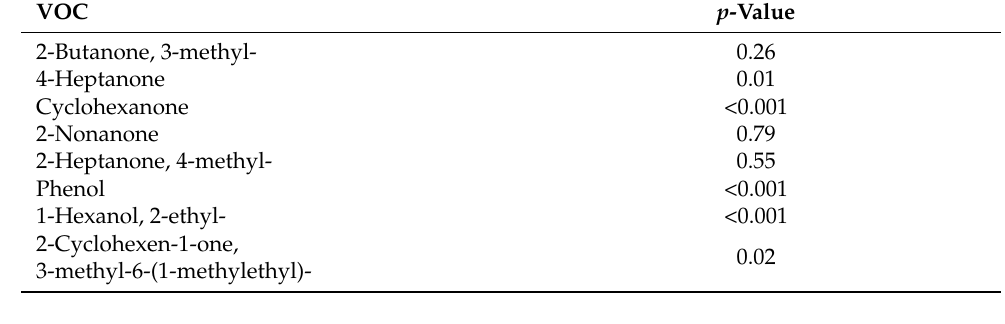
Table 3. Compounds present in at least 70% of samples.